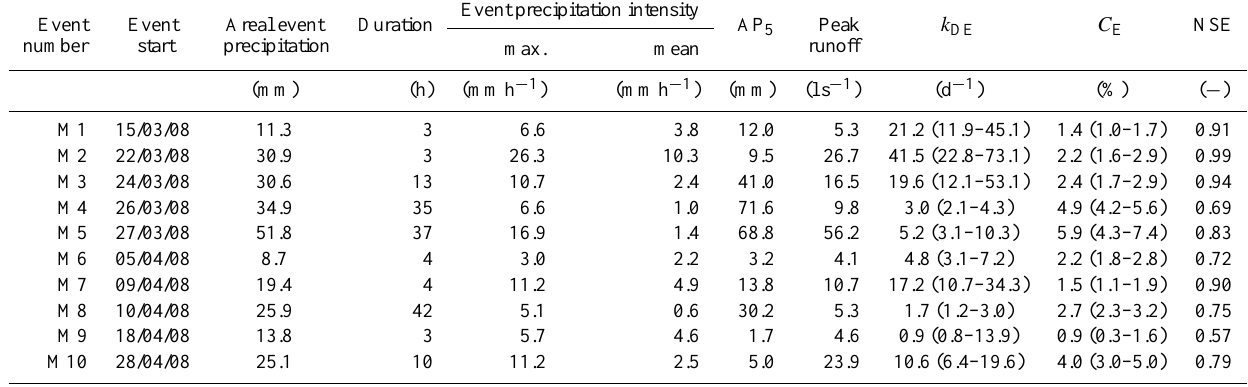
Table 1. Event summaries for the Mataini catchment (M1–M10). AP 5 represents the total precipitation of the preceding 5 days, k DE is the event storage coefficient and RC E is the event runoff coefficient. The values in the brackets show the 95% uncertainty